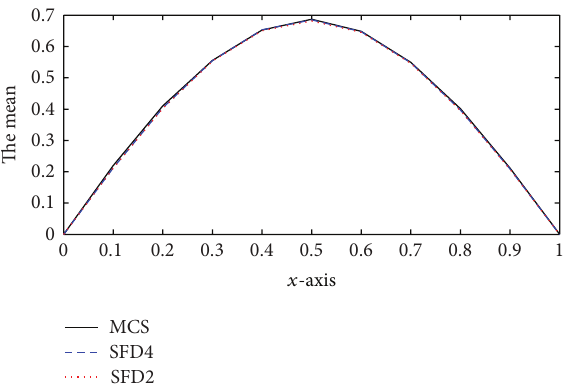
Figure 3: The mean at 𝑡 = 0.04 using SFDHC and MCS.